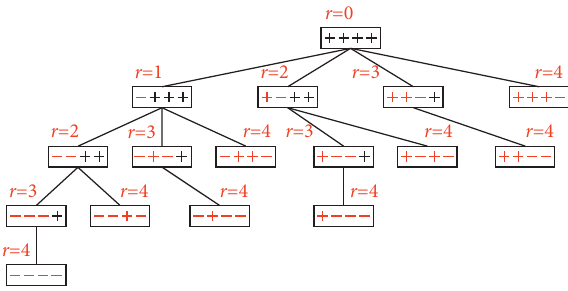
Figure 1: Example of tree containing all combinations of coef- cients' signs in array with four elements. Signs which are uniquely specifed in particular nodes are shown in red, and their count is denoted by r